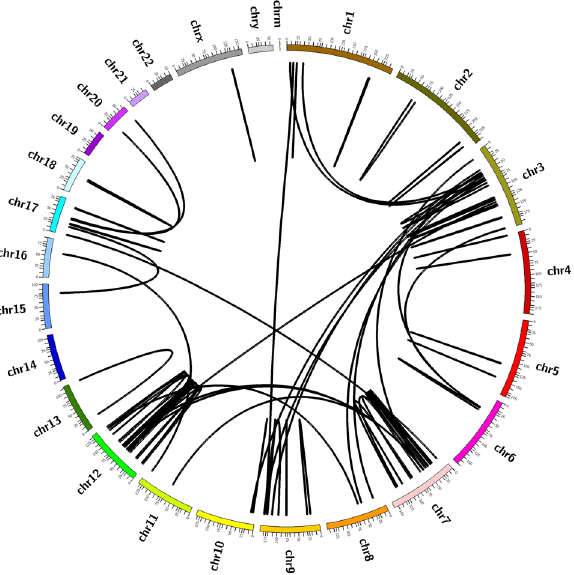
Figure 1. Circos plot showing the chromosomes involved in the fusions detected in this study.